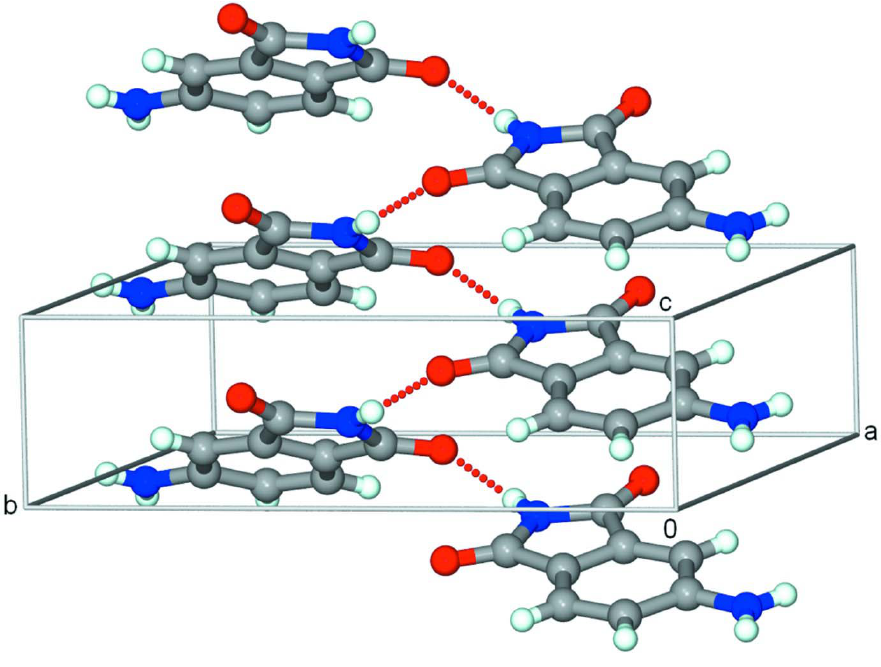
Figure 1 The molecular structure of the title compound with the atom-numbering scheme. Displacement ellipsoids are drawn at the 50% probability level for non-H